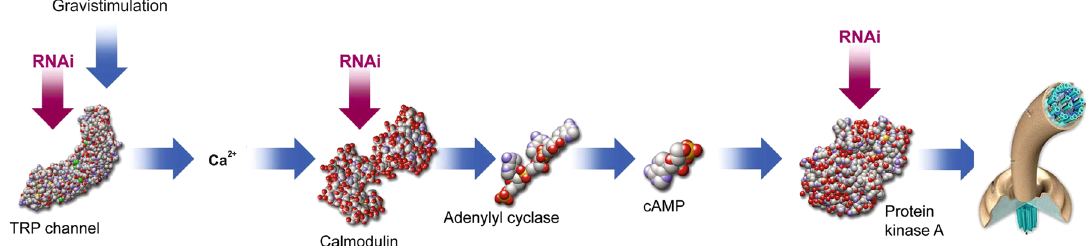
Fig. 1 Schematic model of the gravitactic signal transduction chain in Euglena gracilis (for details, see